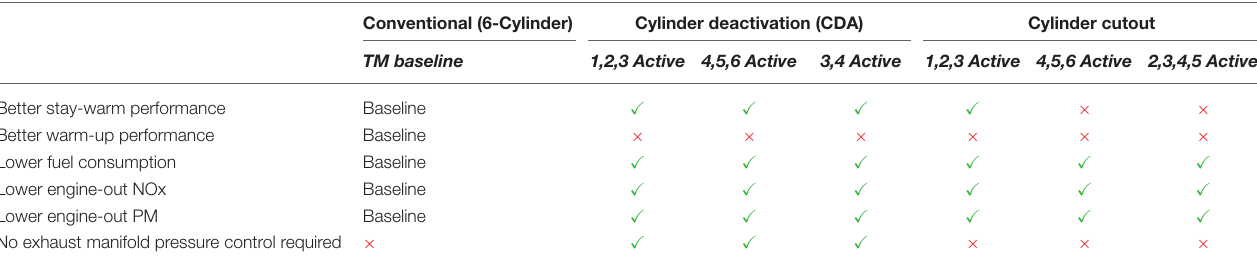
TABLE 1 | Summarized table of results at 800 RPM and 1.3 bar BMEP, comparing each strategy to the TM Baseline for stay-warm performance (at catalyst temperatures above 250 ◦ C ), warm-up performance (at catalyst temperatures below 250 ◦ C ), BSFC, BSNOx, BSPM, and the requirement of exhaust manifold pressure control. Conventional (6-Cylinder)